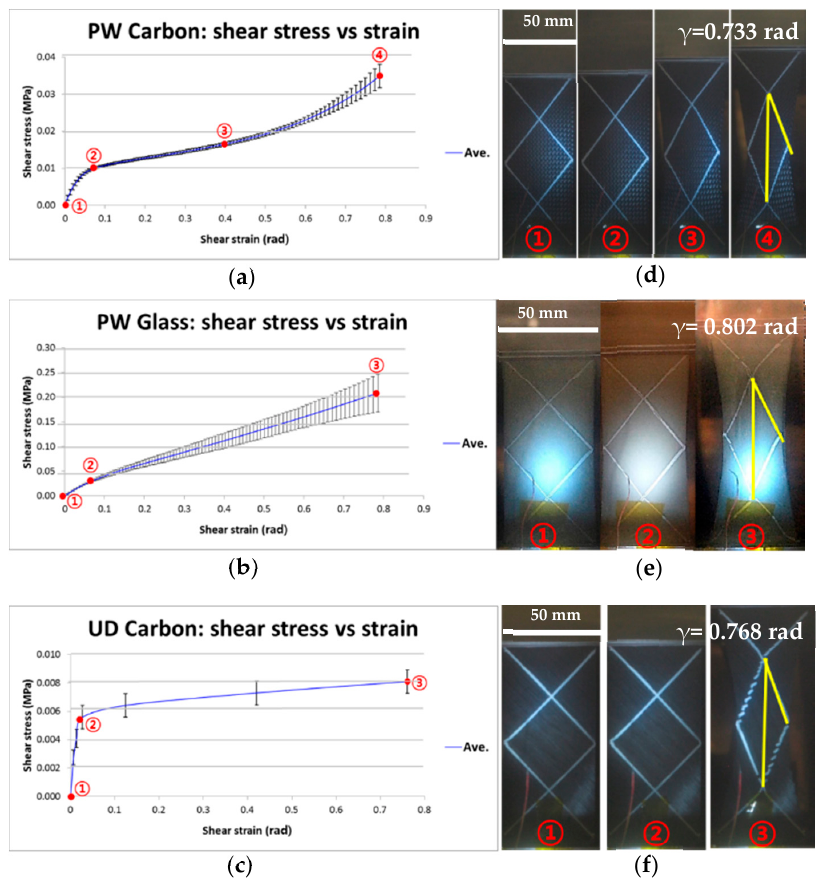
Figure 5. Comparison between the theoretical shear strain (angle) of for ( a ) Plain–woven (PW) carbon; ( b ) PW glass and ( c ) UD carbon prepreg and real shear angle measurements; ( d ) PW carbon; ( e ) PW glass and ( f ) UD carbon prepreg at a high temperature.